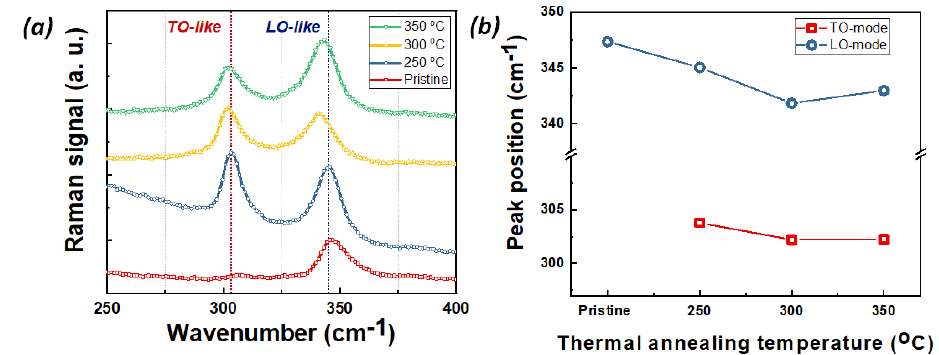
Figure 3. ( a ) Raman spectra and ( b ) the peak position of LO and TO mode in pristine InP:Zn (100) and InZnP:Ag nano ‐ rod samples annealed at 250, 300, and 350 °C,